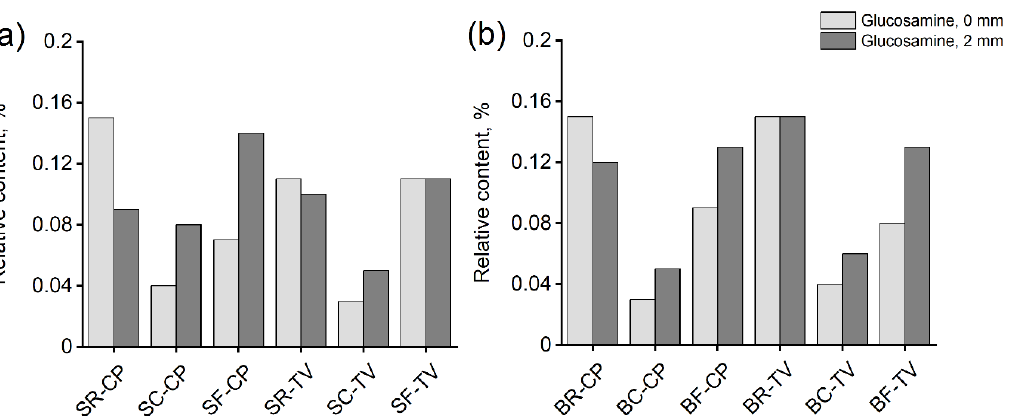
Figure 5. Relative content of glucosamine from the surface (0 mm) and 2 mm beneath the surface in ( a ) spruce and ( b ) birch samples exposed to C. puteana (CP) and T. versicolor (TV). Values are averages of duplicate analyses on pooled samples. R = unmodified; C = contact charred; F = flame charred; S = spruce; B = birch.